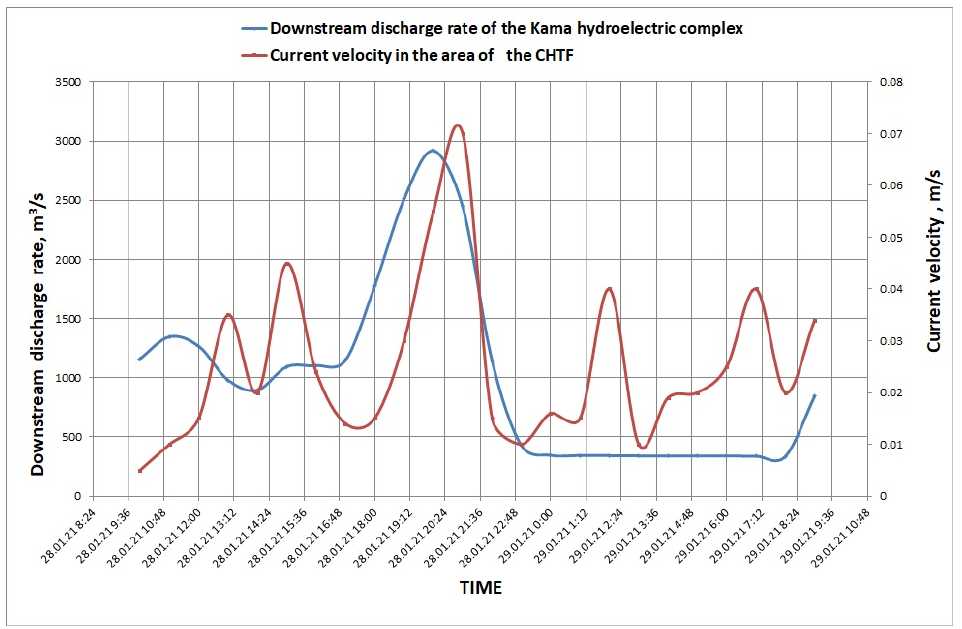
Figure 7. Superimposed chronological graphs of flow rate and modulus of water velocity in the vicinity of the Chusovskoy water intake heads.